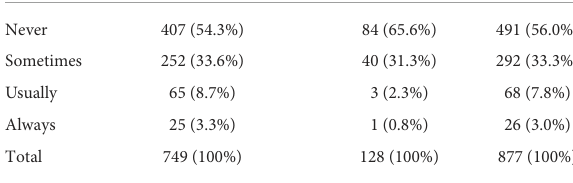
TABLE 2 Contingency table for bullying feelings.